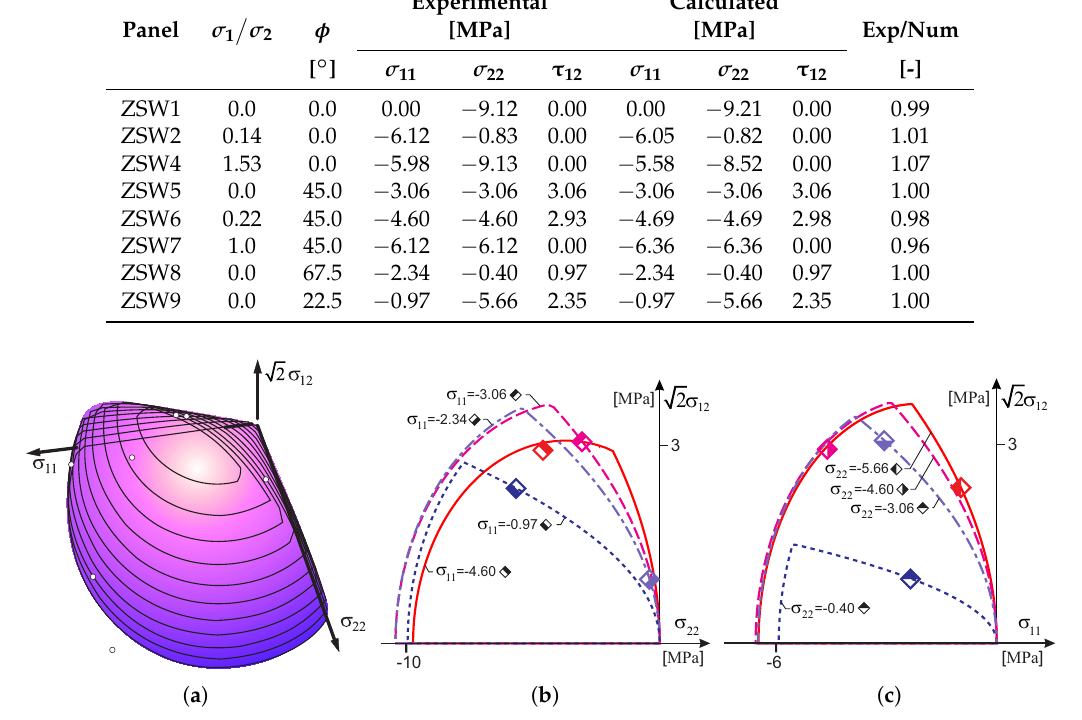
Figure 6. Comparison of the proposed criterion with the experimental results of of Lurati [37]: ( a ) 3D view, ( b ) by cross-sections of the body with σ 22 = const , ( c ) by cross-sections of the body with σ 11 = const